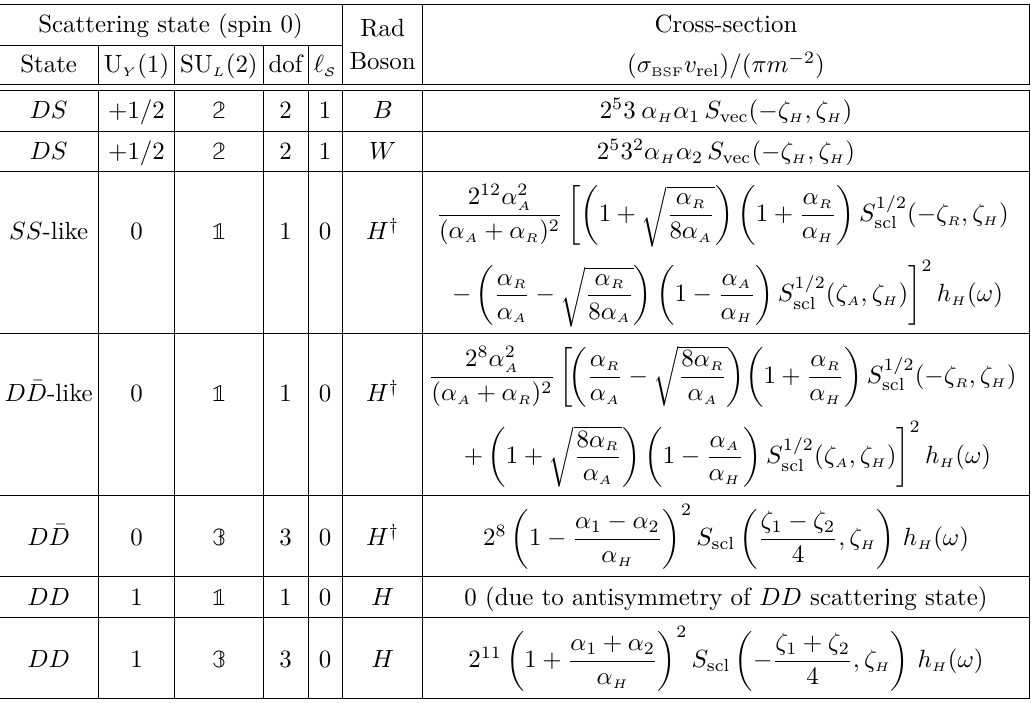
Table 10 . Same as table 10 for the DS bound states. For the SS -like and D should be evaluated from eq. (2.25) for ‘ α R have conjugate